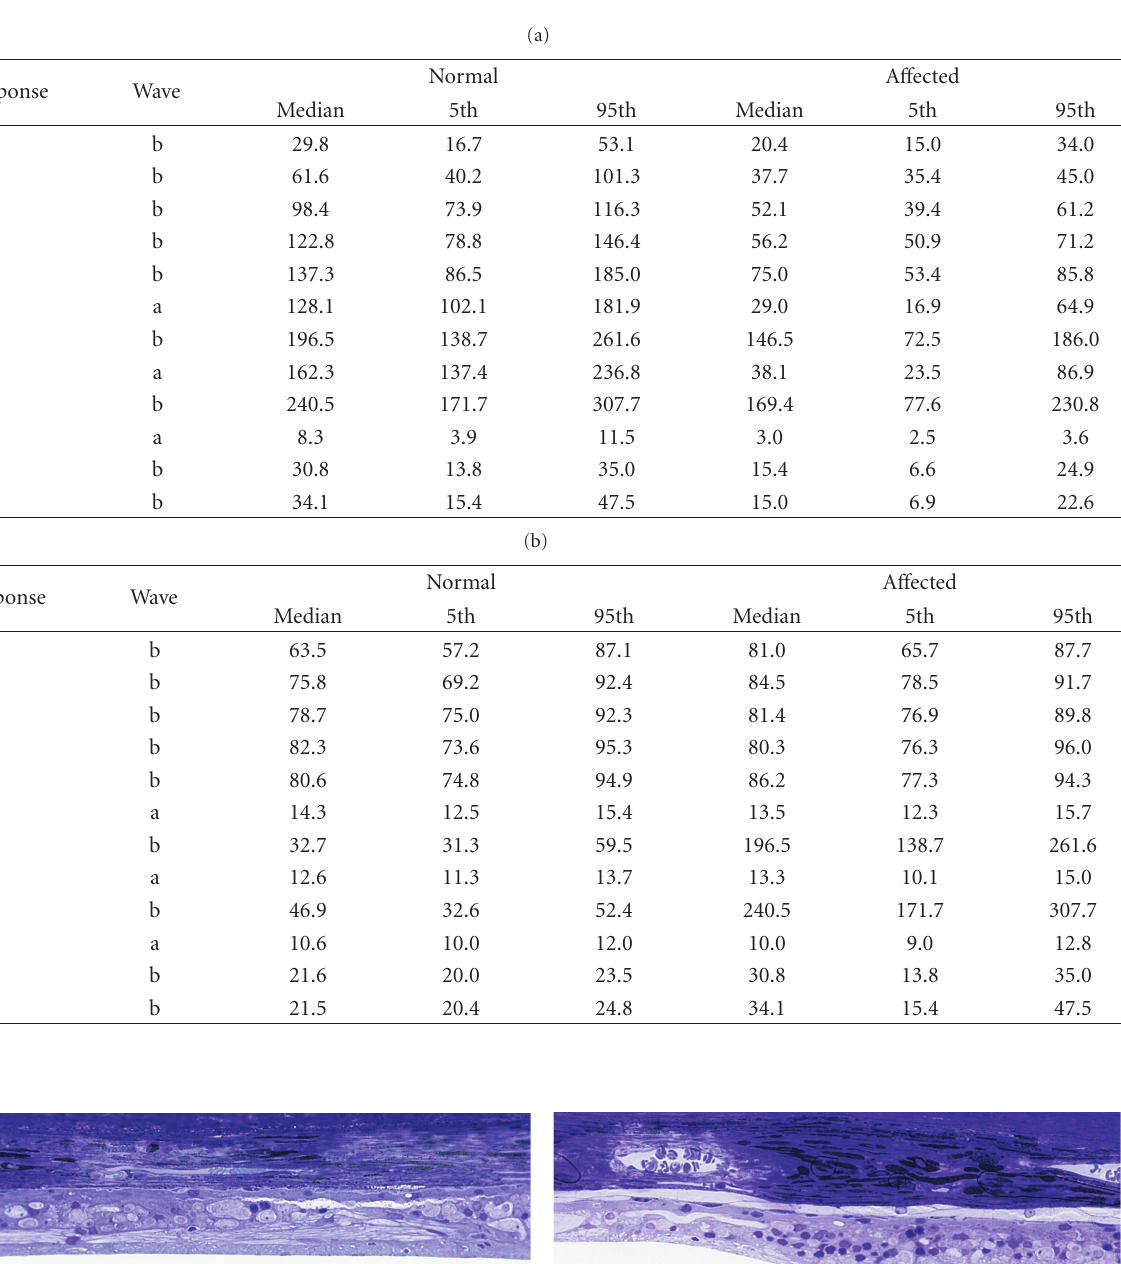
Table 3: ERG amplitude and implicit time for normal and a ff ected ESS dogs in the masked study. Median, 5th and 95th percentiles are given for ERG a- and b-wave amplitudes (a) in microvolts and in (b) for implicit times in milliseconds, for normal and a ff ected ESS dogs. Scotopic ERGs consisted of scotopic low-intensity responses (S: 0.01 cd · s/m 2 ), which were elicited 4, 8, 12, 16, and 20 minutes after dark adaptation designated: S1, S2, S3, S4, and S5, scotopic standard intensity responses, Ssd: 3 cd · s/m 2 , and scotopic higher intensity responses,